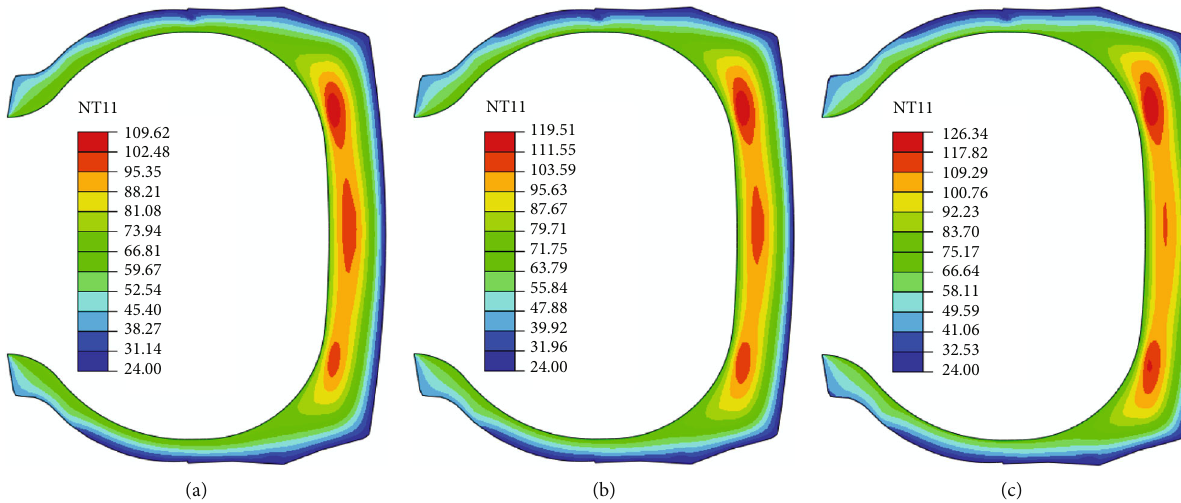
Figure 8: Tire temperature fi eld distribution under loads of (a) 466667 N, (b) 550000N, and (c) 633330N when the in fl ation pressure is 0.6MPa, and the speed is 15